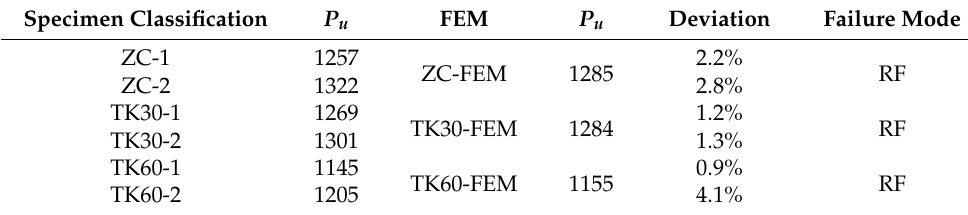
Figure 25. Analysis results for reinforcement diameters:( a ) Load-slip curves; ( b ) Comparison of ultimate shear capacity. Table 10. Comparison of FEM and experiment.